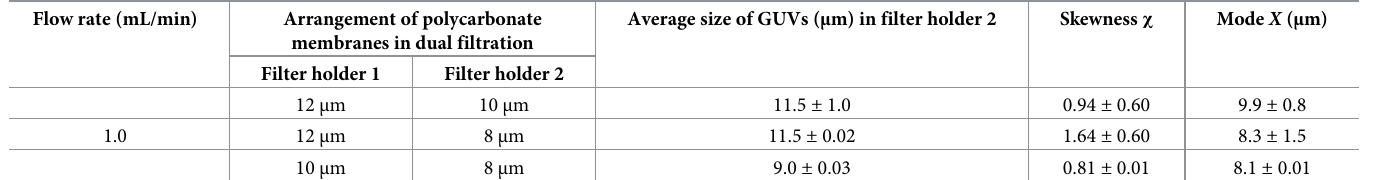
Table 1. The average size of GUVs, skewness and mode of the distribution for different combinations of polycarbonate membrane. Flow rate (mL/min) Arrangement of polycarbonate membranes in dual